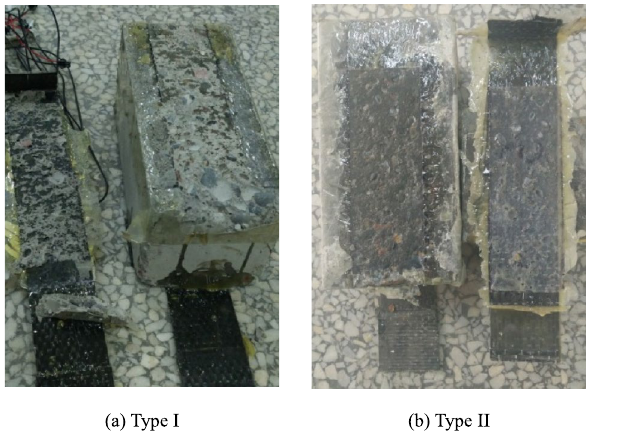
Figure 5. Typical damage patterns of